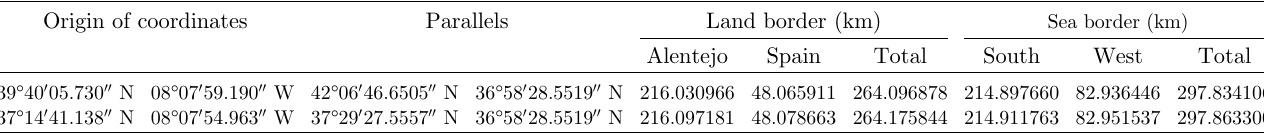
Table 9. Borders of the Algarve by using OAM Algarve (1st line) and NAM Algarve (2nd line) with LCC. Origin of coordinates Parallels Land border (km) Sea border (km) Alentejo Spain Total South West Total